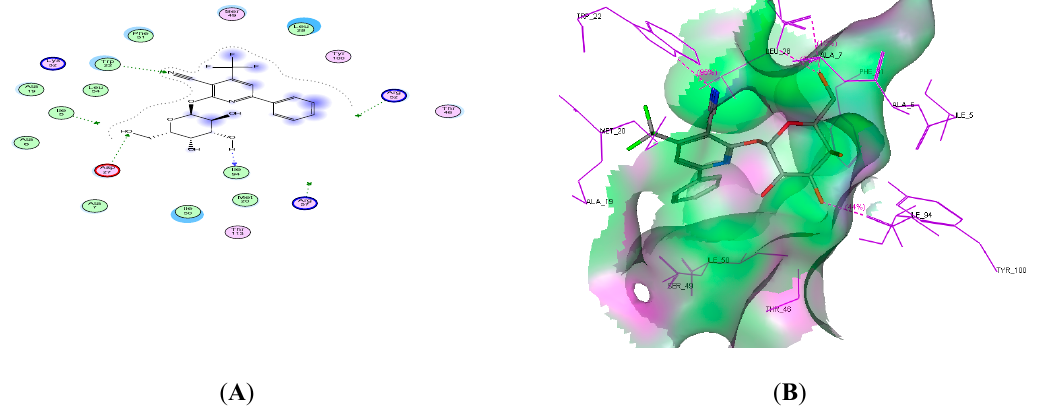
Figure 5. ( A ) 2D interactions of compound 14 c with the DHFR binding site. ( B ) 3D interactions of compound 14 c with the DHFR binding site.